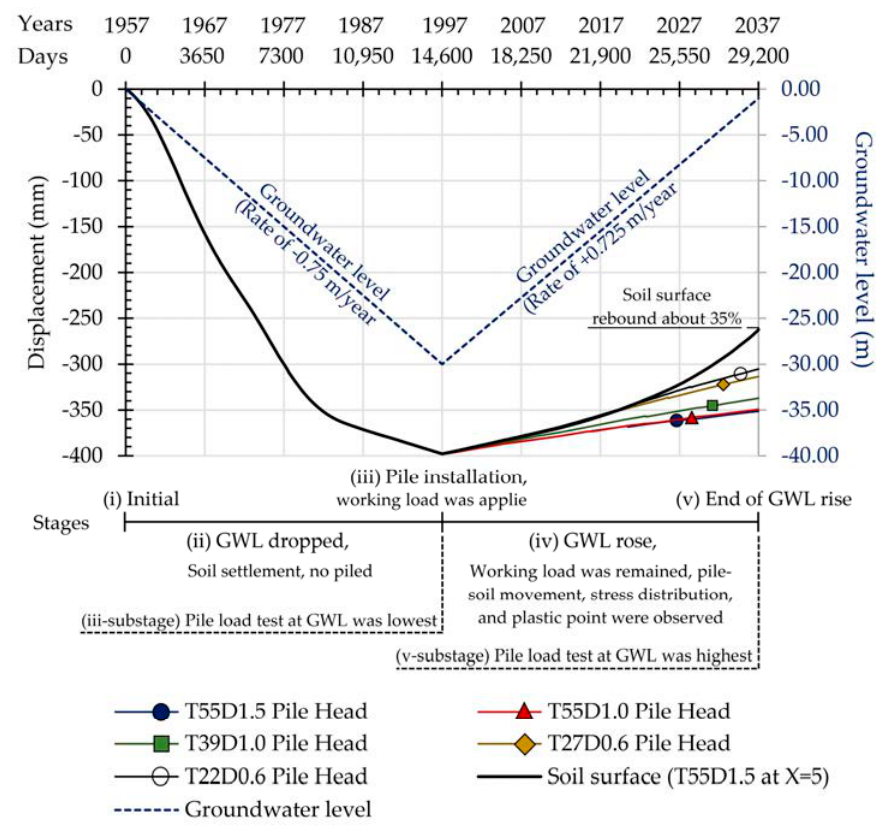
Figure 8. Pile–soil movements with groundwater level change.